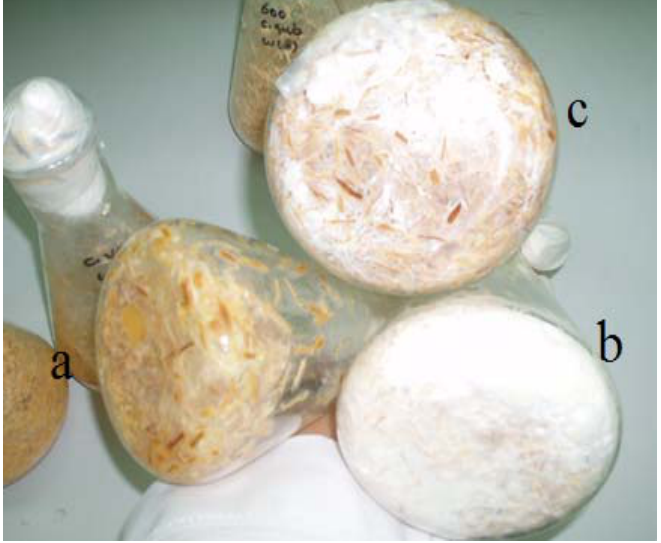
Figure 1. Biological pretreatment of rubberwood after 90 d: ( a ) C.subvermispora ; ( b ) T.versicolor ; ( c ) Mixed